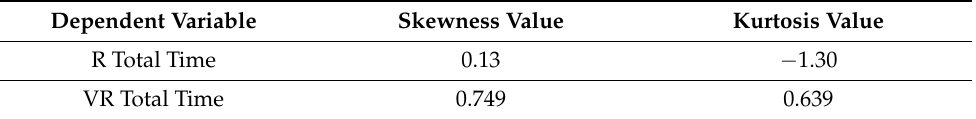
Table 2. Skewness and Kurtosis of total time.